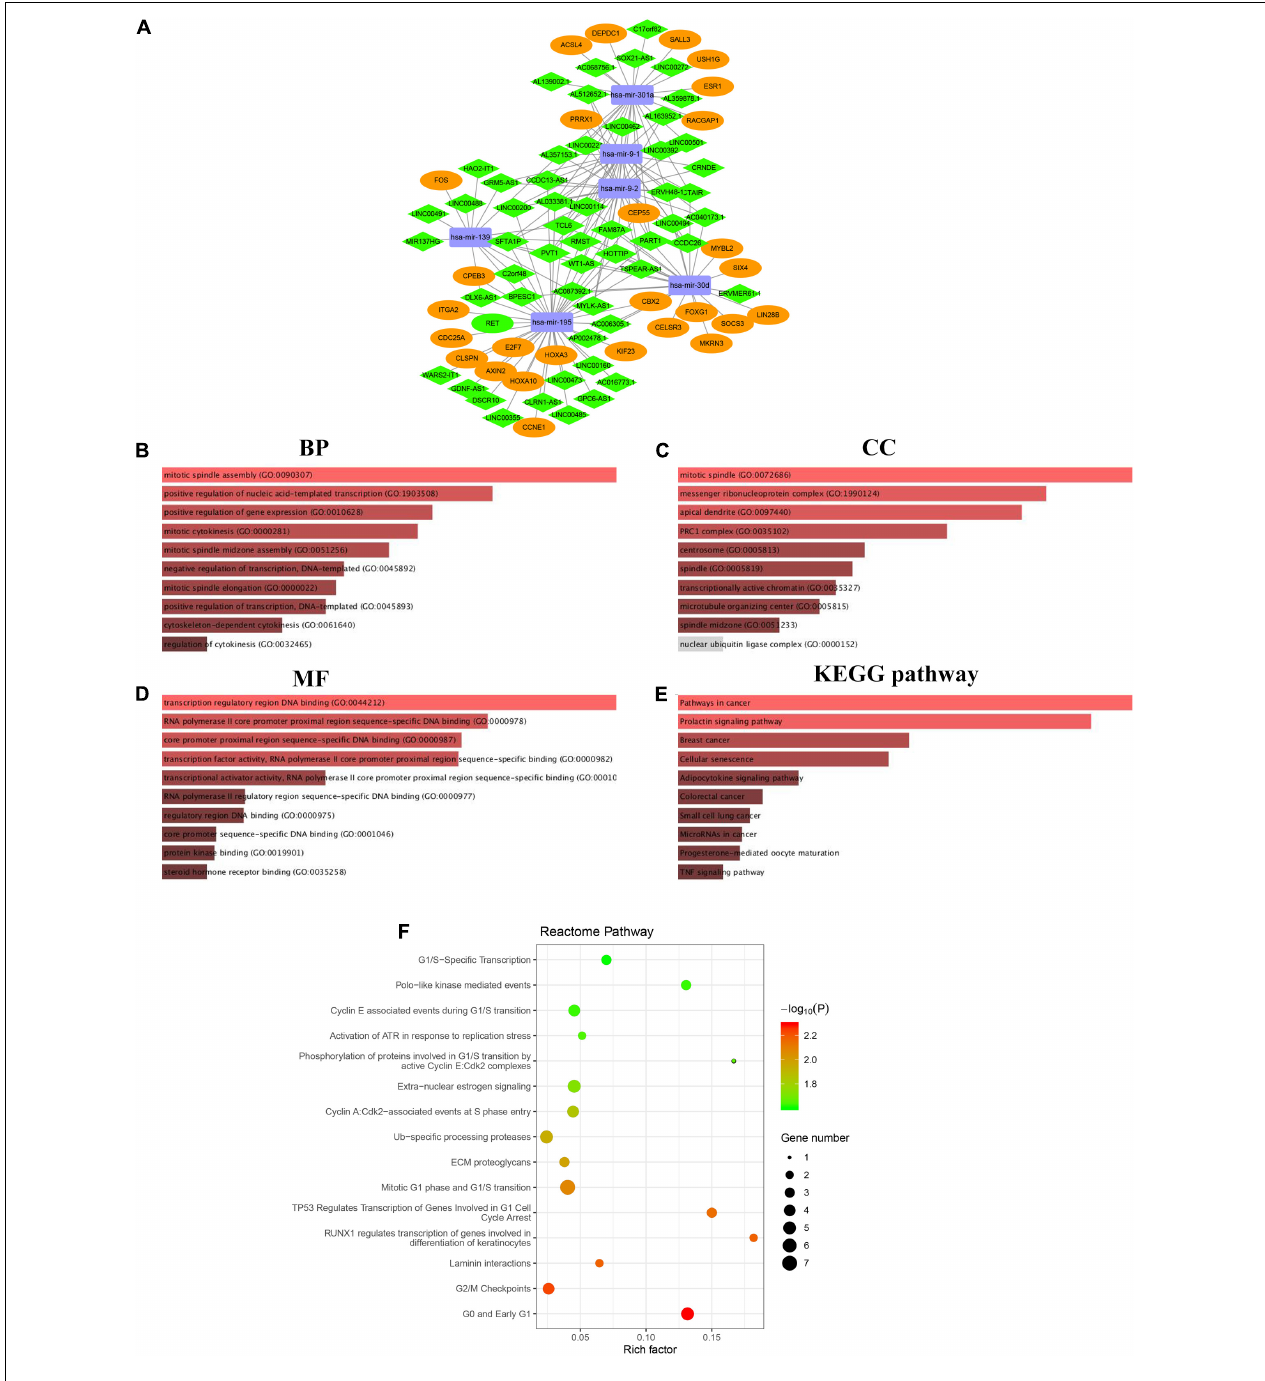
FIGURE 5 | The lncRNA-miRNA-mRNA regulatory network in HCC cohort visualized by Cytoscape software 3.6.1 (A). Rectangle represent the 6 DEMs, diamond represent the 56 DELs, the ellipse represent the 28 DEGs. The functional enrichment analysis of DEGs correlated to ceRNA network (B–F). Top 10 biological process (BP) terms (B) . Top 10 cell components (CC) terms (C) . Top 10 molecular functions (MF) terms (D) . Top 10 significantly KEGG pathways (E) . Top 15 enriched Reactome pathways (F) .